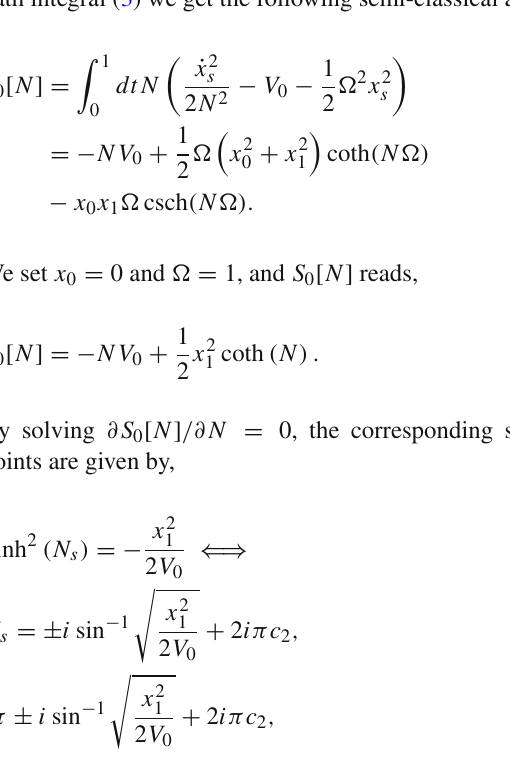
Fig. 3 The top and bottom figures show 3D-plot of Re where we take V 0 = 1 and x 1 = 1 for harmonic and inverted harmonic oscillator models, respectively. The Lefschetz thimbles J σ on the lapse integral is taken along the imaginary y -axis in the harmonic oscilla- tor whereas it is taken along the real x -axis for the inverse harmonic